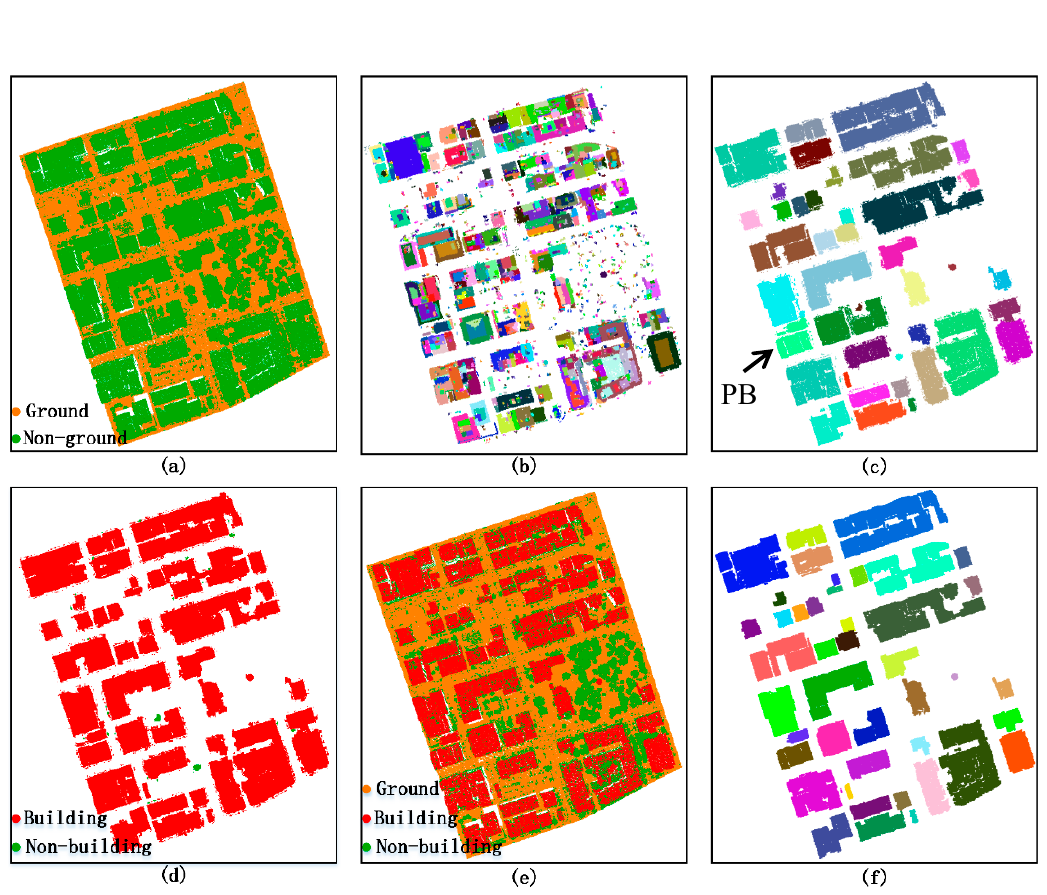
Figure 10. Detecting buildings from the Toronto dataset. ( a ) Filtering result; ( b ) Non-ground segments, and each segment is dotted in one color; ( c ) Result of generating building candidate regions, where each region is dotted in one color; ( d ) Result of TRG classification; ( e ) Result of extracting buildings; ( f ) Result of the extracted buildings, and different buildings are dotted in different colors.